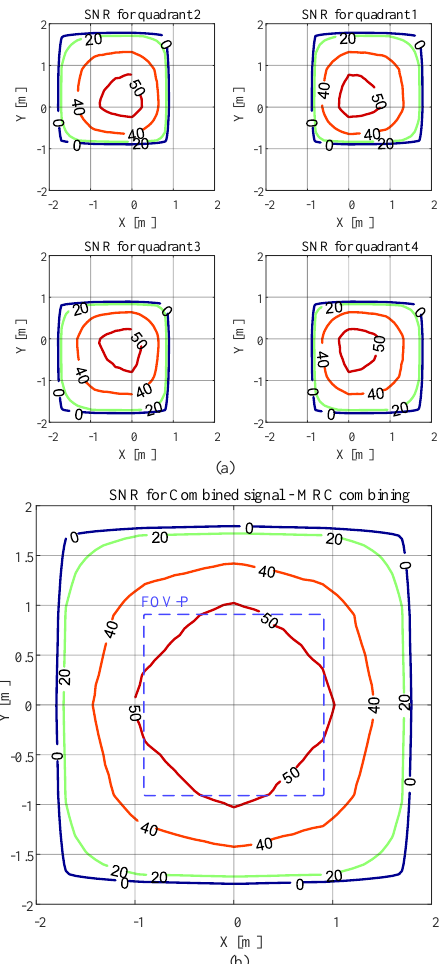
Figure 9. SNR in dB versus QADA location in an area equipped with a single transmitter with m = 1 and with the receiver parallel to the plane on which the luminaire is located with a FOV-C of 45 ◦ for ( a ) each quadrant; ( b ) the combined signal using